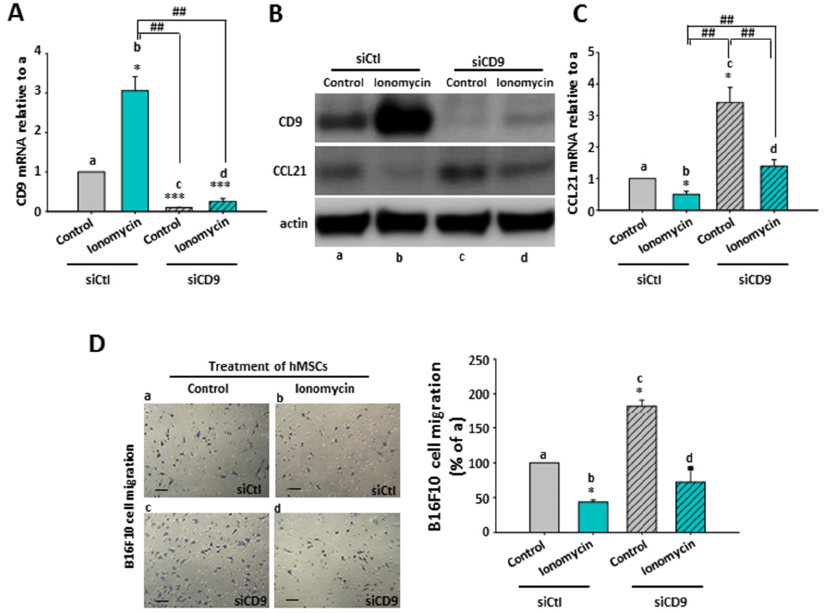
Figure 7. Effect of hMSCs’ CD9 knockdown on ionomycin-mediated hMSCs’ CCL21 downregulation and B16F10 cell migration inhibition. ( A ) CD9 siRNA (siCD9) downregulated hMSCs’ basal CD9 mRNA ( a vs. c ) and suppressed ionomycin-upregulated CD9 mRNA ( b vs. d ). The relative CD9 mRNA levels are presented as the mean ± SEM of three independent experiments. * p < 0.05; *** p < 0.001 as compared with ( a ). ## p < 0.01. ( B ) CD9 siRNA (siCD9) decreased cellular basal CD9 protein ( a vs. c ) and inhibited ionomycin-upregulated CD9 mRNA ( b vs. d ); however, CD9 siRNA (siCD9) increased cellular basal CCL21 protein ( a vs c ) but also reversed ionomycin-decreased cellular CCL21 protein ( b vs. d ) in hMSCs. Western blot images are shown as representative of at least three independent experiments with similar results, and actin was used as a loading control. ( C ) CD9 siRNA (siCD9) upregulated hMSCs’ basal CCL21 mRNA ( a vs. c ) but also inverted ionomycin-inhibited CCL21 mRNA ( b vs. d ). The relative CCL21 mRNA levels are presented as the mean ± SEM of three independent experiments. * p < 0.05 as compared with ( a ). ## p < 0.01. ( D ) B16F10 cells with ionomycin-incubated siCtl hMSC-derived conditioned media in the bottom chamber showed reduced cell migration ( a vs. b ). B16F10 cells with siCD9-infected hMSC-derived conditioned media in the bottom chamber showed increased cell migration ( a vs. c ). An antagonism between ionomycin and siCD9 in B16F10 cell migration was observed in the conditioned media from ionomycin-incubated hMSCs infected with siCD9 ( d ). Left panel: representative images of the migration of B16F10 cells by crystal violet staining. Scale bar: 20 µ m. Right panel: quantification of the migration of B16F10 cells. Data are presented as the mean ± SEM of three independent experiments. * p < 0.05 as compared with ( a